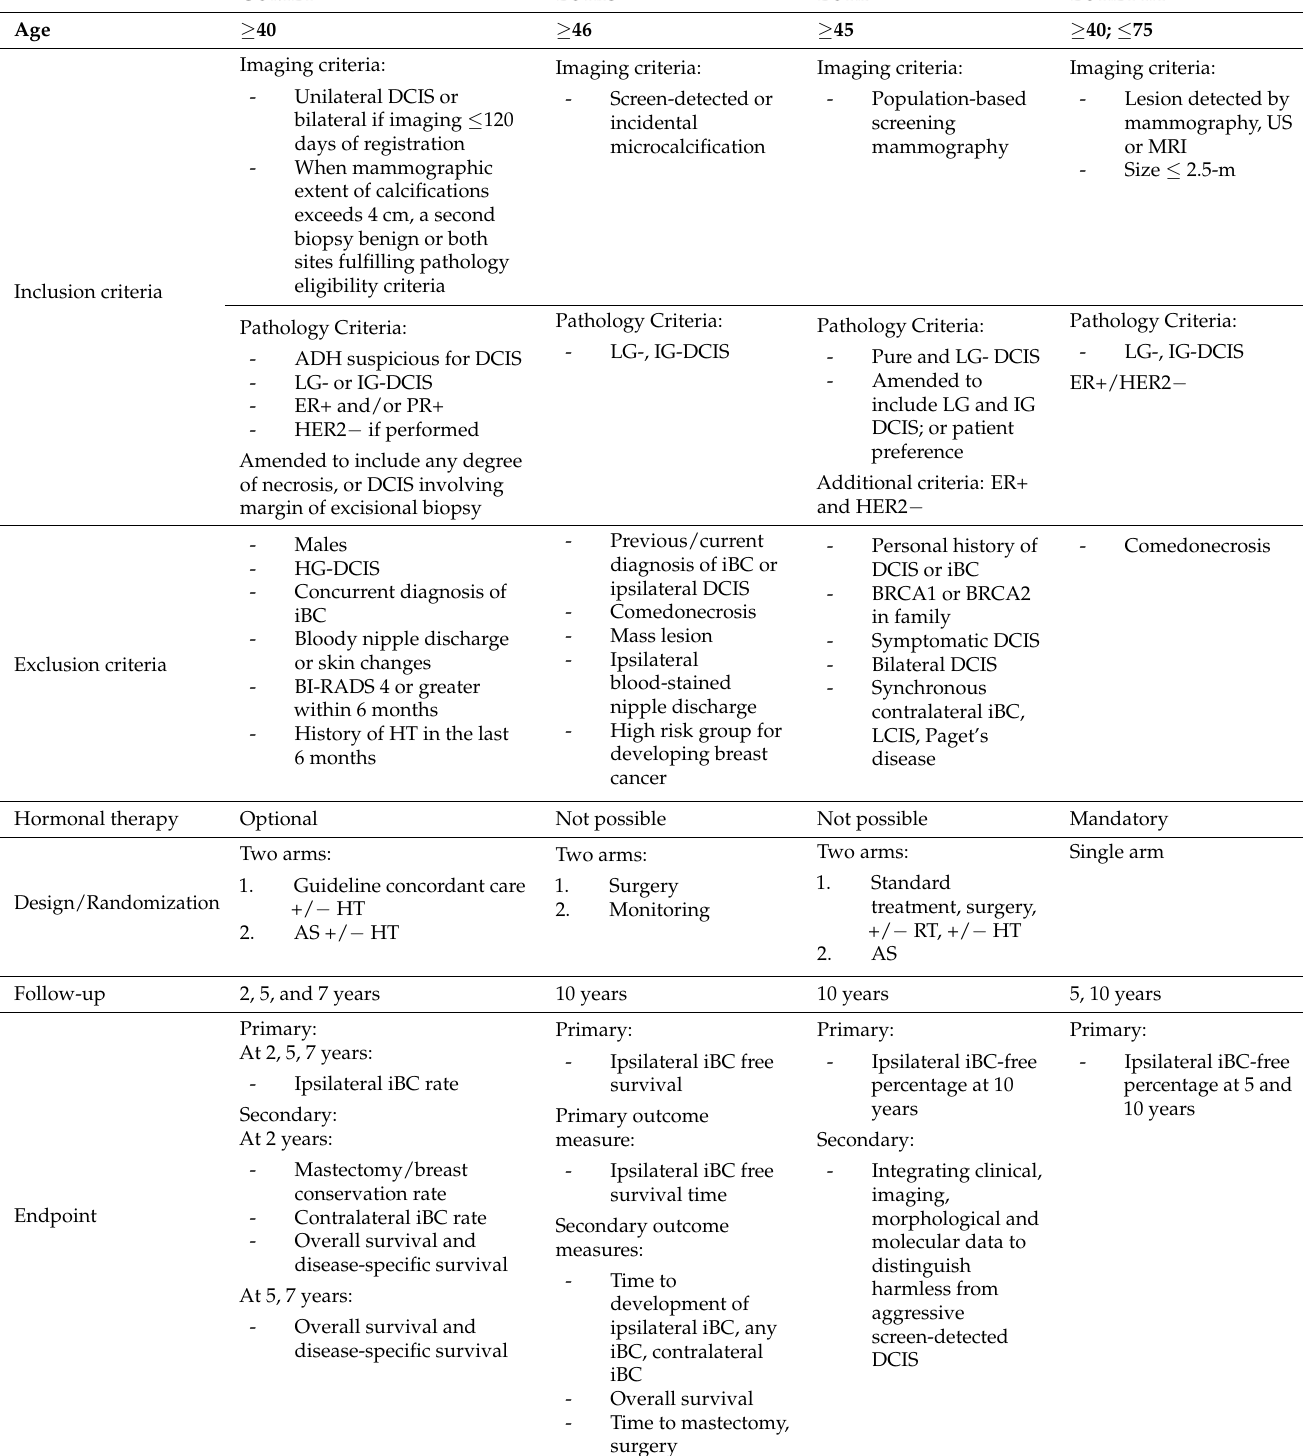
Table 1. Randomized active surveillance trials for low-risk